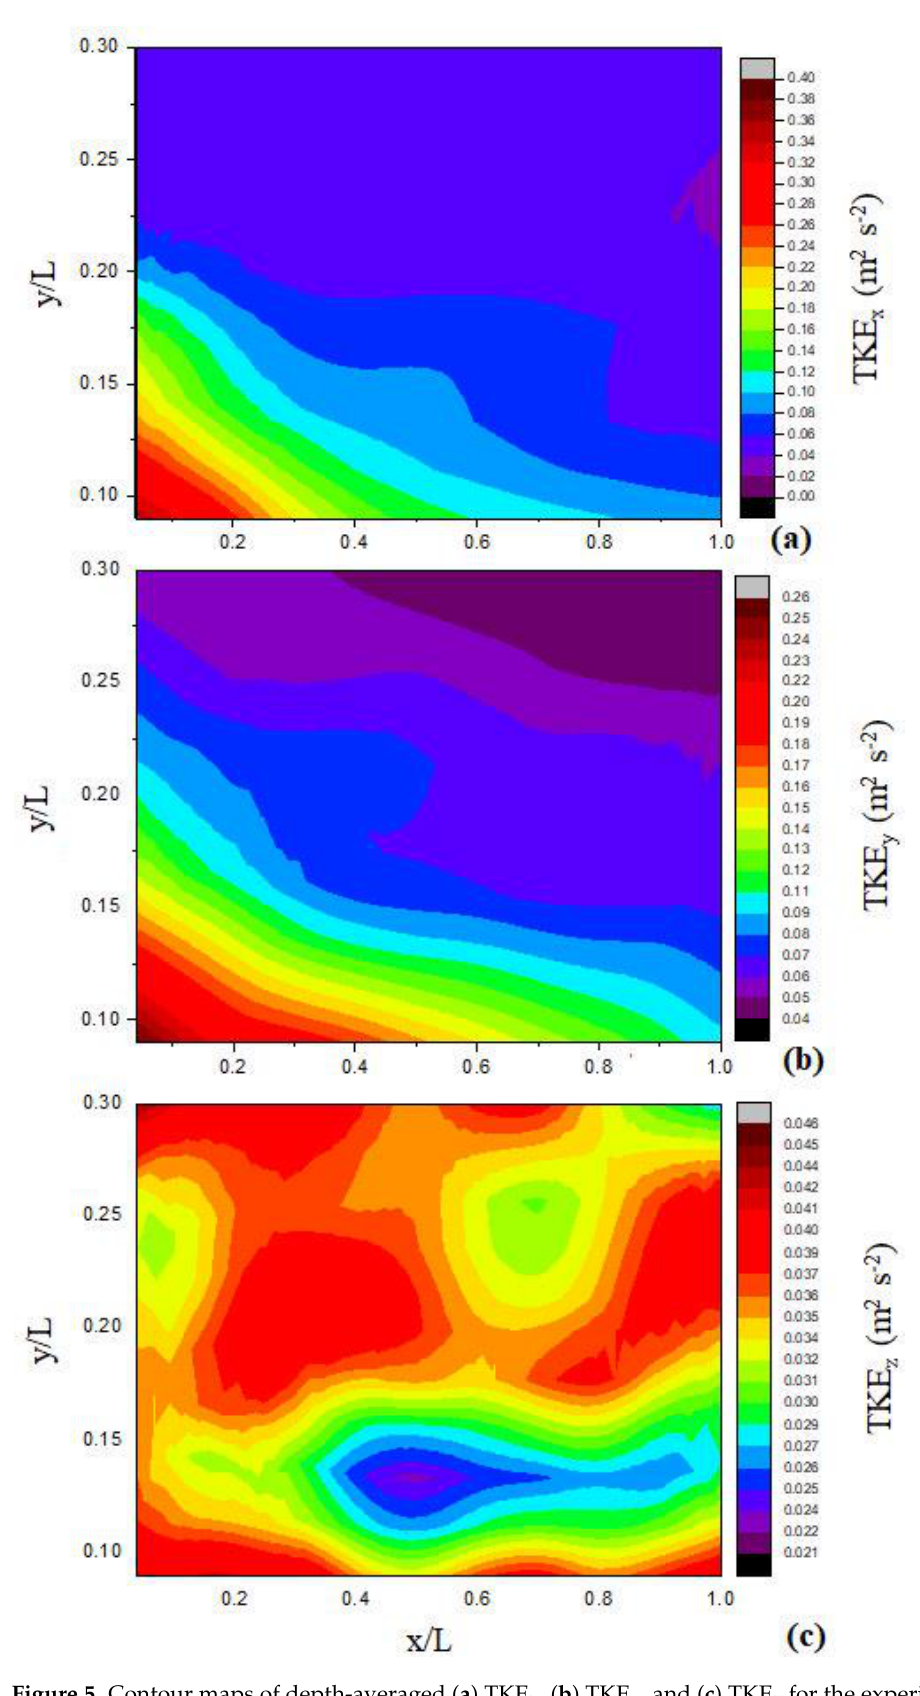
Figure 5. Contour maps of depth-averaged ( a ) TKE x , ( b ) TKE y , and ( c ) TKE z for the experimental run 4R.